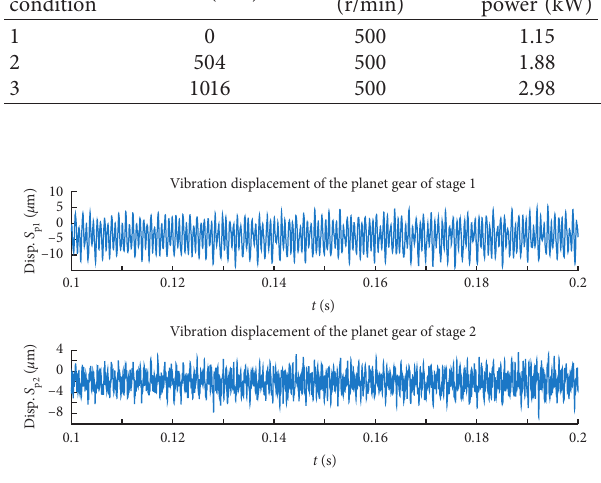
Figure 5: Vibration displacement of the planetary gear.